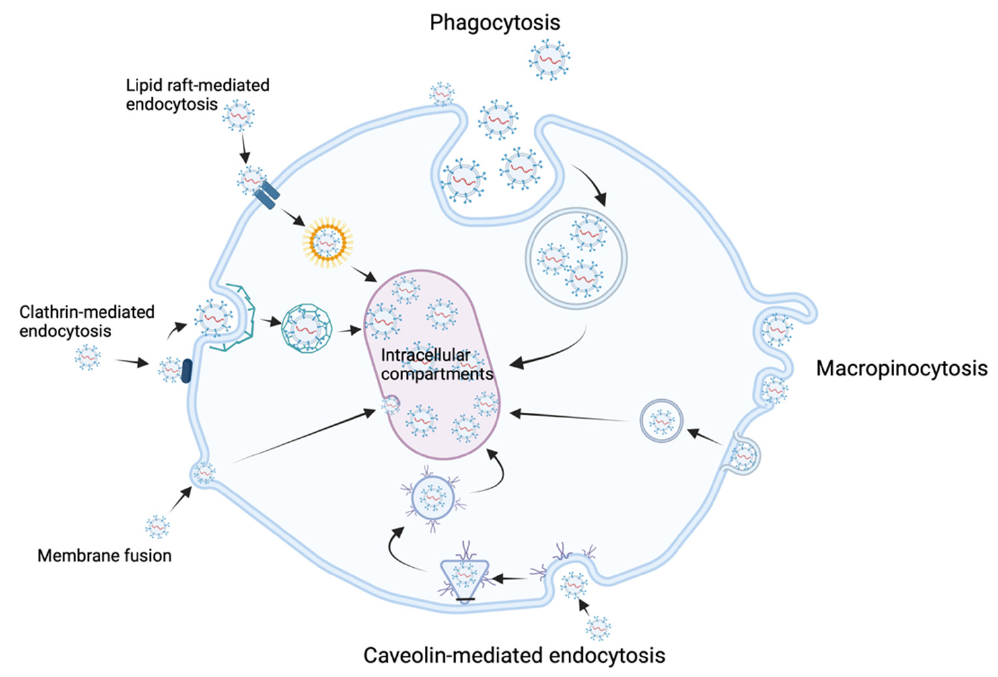
Figure 2. Exosomal uptake Figure 2 . Exosomal uptake mechanisms . Figure 2 . Exosomal uptake mechanisms .